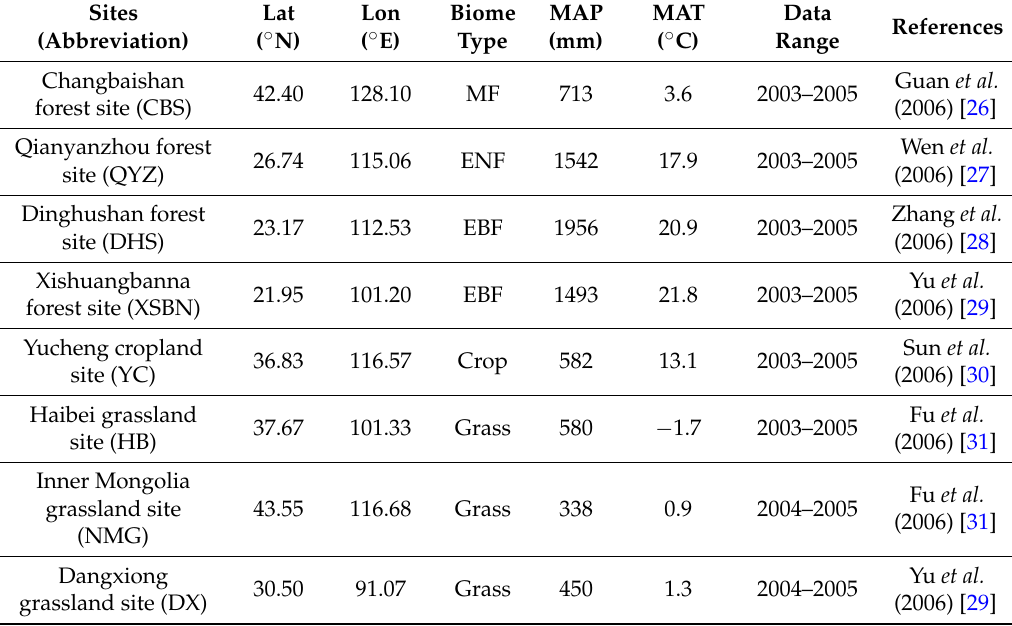
Figure 1. Locations of the eight flux tower sites used in this study. MF: Mixed forest; ENF: Evergreen needleleaf forests; EBF: Evergreen broadleaf forests; Crop: Croplands; Grass: Grasslands. Table 1. Site descriptions including name (abbreviation), latitude and longitude (lat/long, decimal degrees), general biome type, mean annual long-term precipitation (MAP, mm), mean annual temperature (MAT, °C), years of measurements and references. MF: Mixed forest; ENF: Evergreen needleleaf forests; EBF: Evergreen broadleaf forests; Crop: Croplands; Grass: Grasslands.